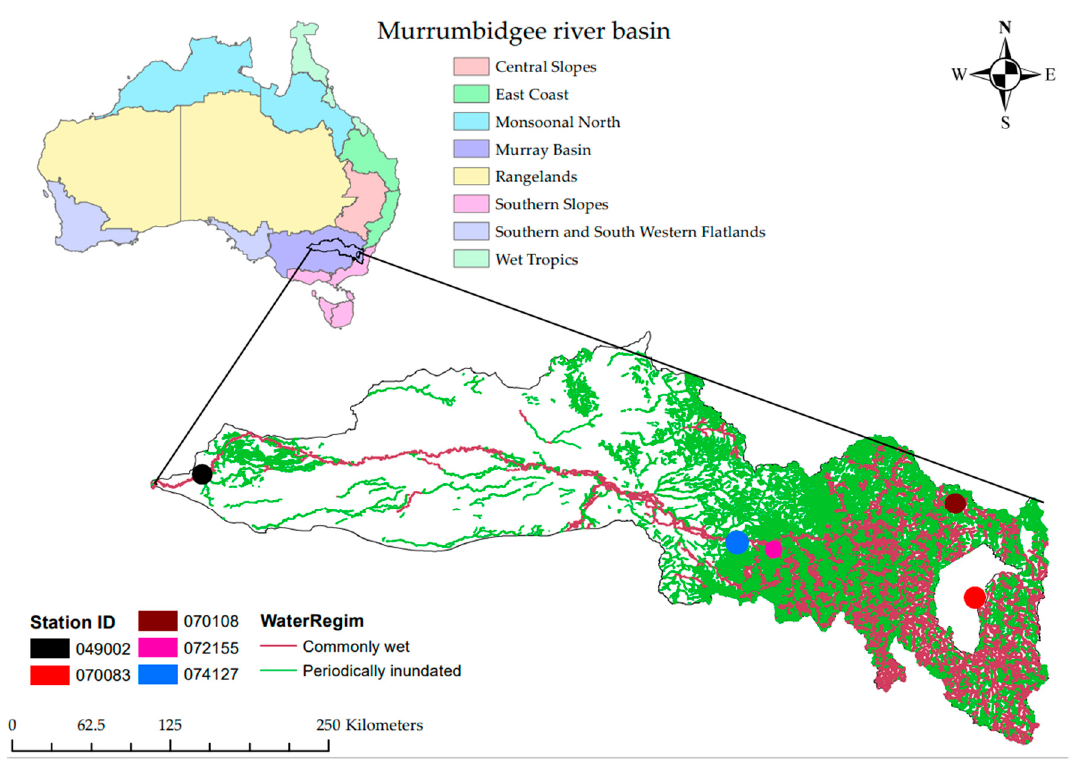
Figure 1. Murrumbidgee River basin study area is located within the Murray Darling Basin in the southeast part of Australia.